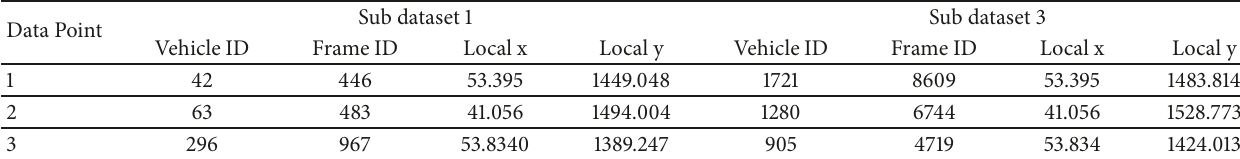
Table 2: Examples with the same global coordinates in the first and third